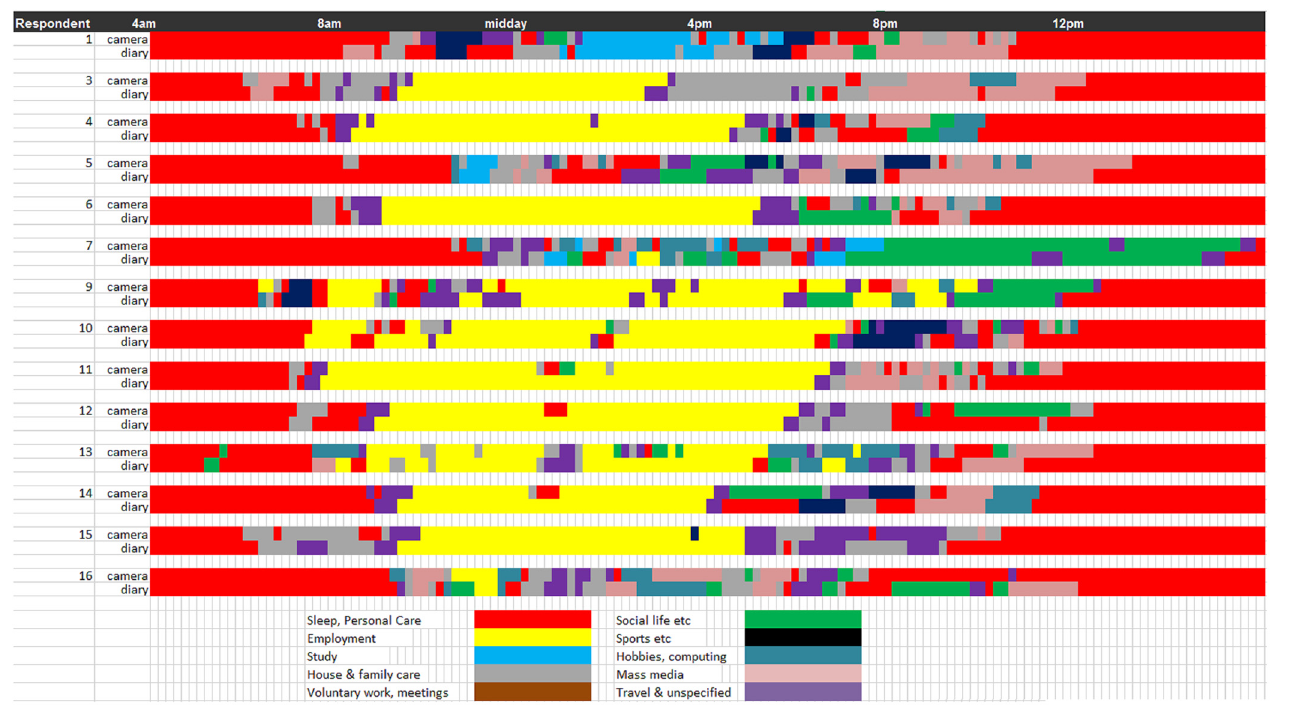
Fig 3. Sequence plot comparison for each participant (n = 14) of camera and diary measures (single digit activity classification).